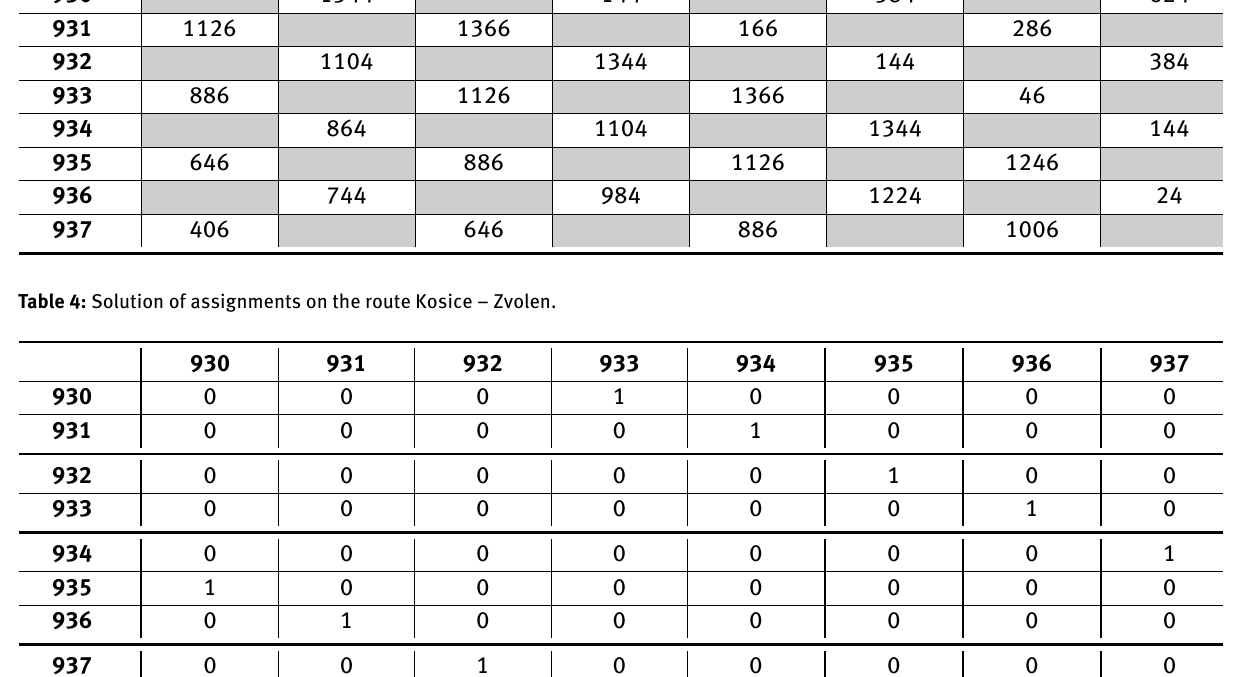
Table 3: Time differences between departures and arrivals of trains. min